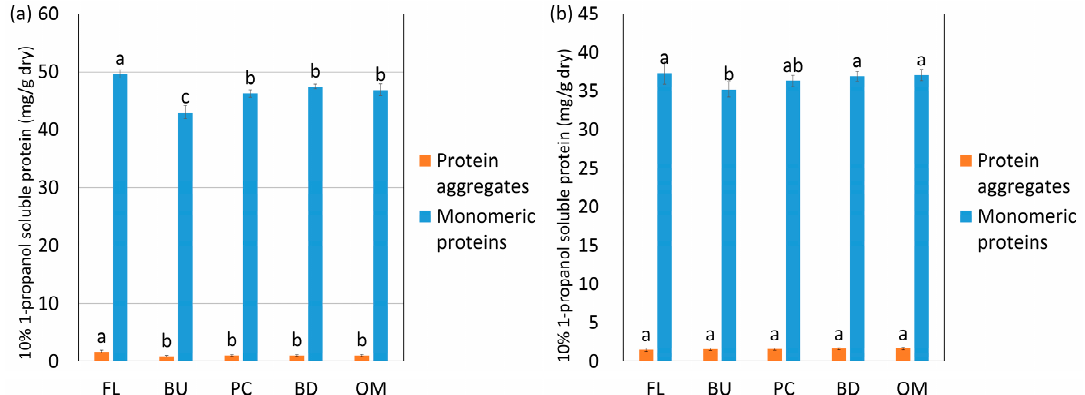
Figure 5. Changes in the amount of protein aggregates and monomeric proteins extracted with 10% 1-propanol during mixing from high-protein flour (HF) ( a ) and low-protein flour (LF) ( b ). FL, BU, PC, BD and OM indicate flour (before mixing), buildup, peak consistency, breakdown, and overmixing, respectively. Protein aggregates mean “A”, and monomeric proteins mean “B” in Figure 2. The error bars show standard deviations ( n = 6). Different letters on the graph indicate significant differences ( p < 0.05).